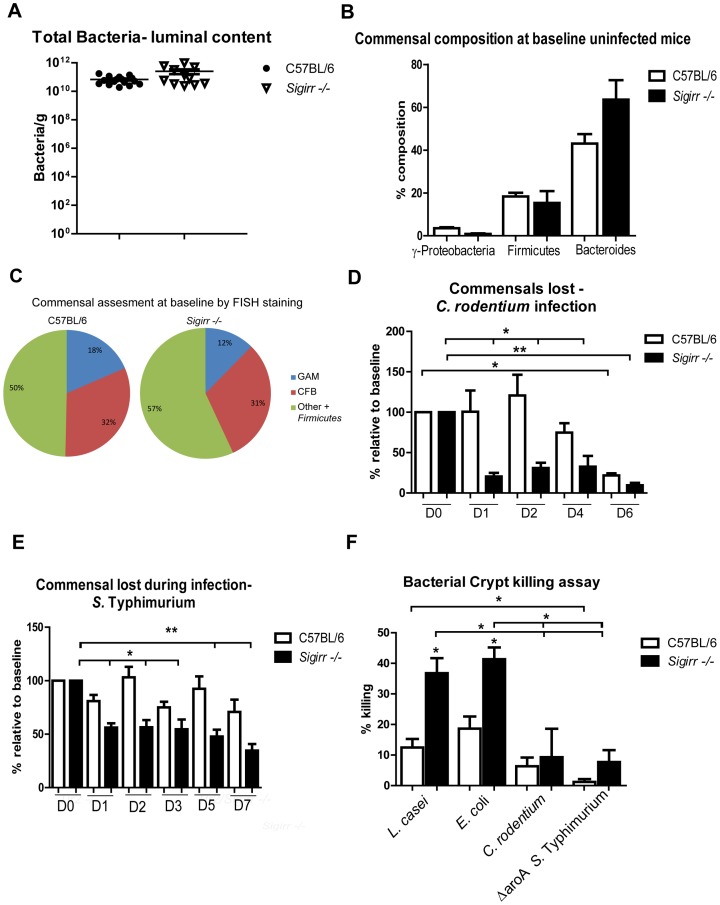

Sigirr −/− mice display strong antimicrobial activity against commensal microbes.No significant differences were found between (A) the commensal microbiota found in WT and Sigirr −/− mice as measured by (B) qPCR and (C) FISH staining. Rapid commensal depletion in Sigirr −/− mice was observed as early as D1 pi by C. rodentium (D) and S. Typhimurium (E) while intestinal crypts isolated from Sigirr −/− mice (F) possess greater killing activity against commensal E. coli and Lactobacilli. Results are pooled from 2–3 independent experiments (or infections) with n = 3–5 per group. Error bars = SEM, (Student t test (Figure A) one way ANOVA (Figures B–F, *P<0.05, **P<0.01).